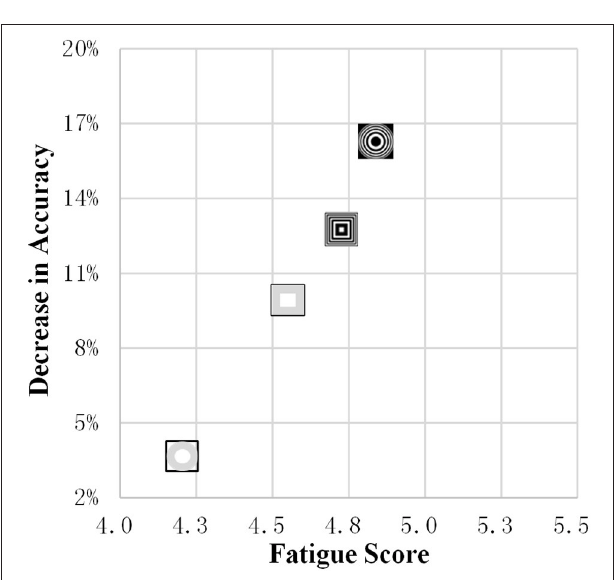
FIGURE 10 | The fatigue score and decrease in